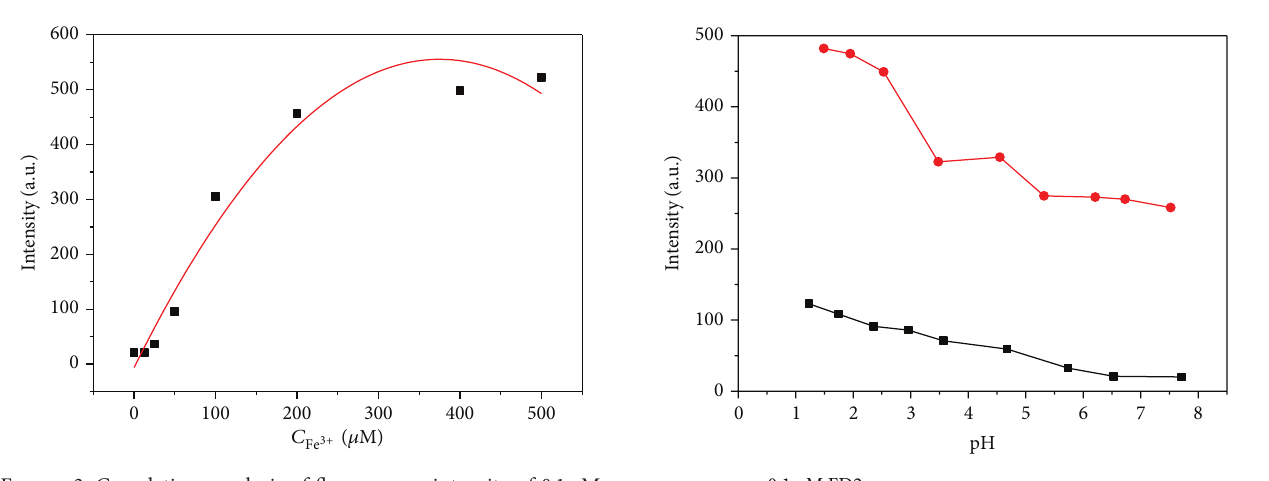
Figure 3: Correlations analysis of fluorescence intensity of 0.1 𝜇 M FD2 with Fe 3+ ions concentration.